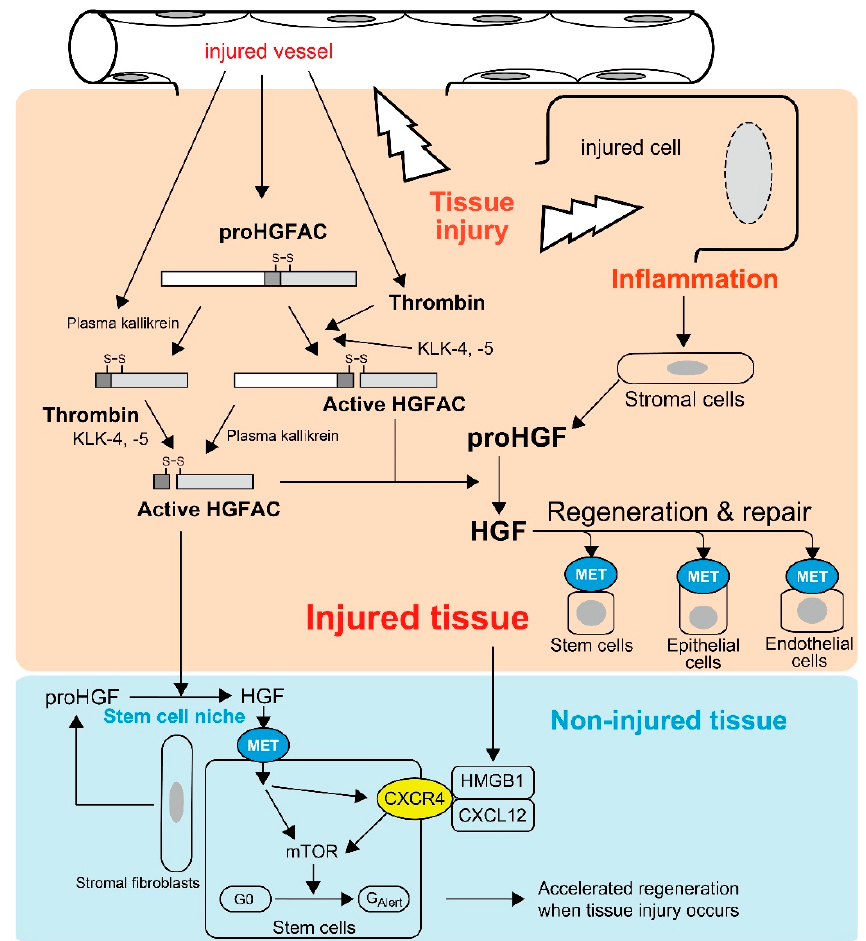
Figure 1. Tissue injury-induced activations of proHGF by HGFAC in response to tissue injury. Thrombin efficiently activates plasma-derived proHGFAC. KLK-4 and -5 also activate proHGFAC as well. Activated HGFAC is also released into the bloodstream and serves as an “alarmin” for tissue stem cells of non-injured tissue to prepare for the regeneration phase. Injured cell-derived HMGB1 also serves as a similar alarmin through CXCR4, and HGF-MET signaling upregulates CXCR4 expression in stem cells.